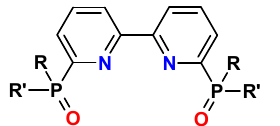
Figure 14. P,P,P′,P′-tetraphenylpyridine-2,6-diphosphine oxide PyDPO .